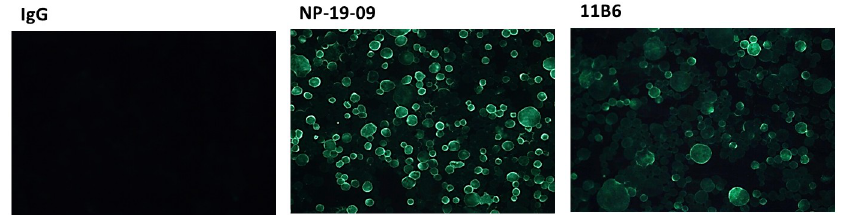
Fig 4. Binding affinity test between mAbs and ERA G protein expression cells. NP-19-9 and 11B6 have binding capacity to the ERA G protein expression cells.